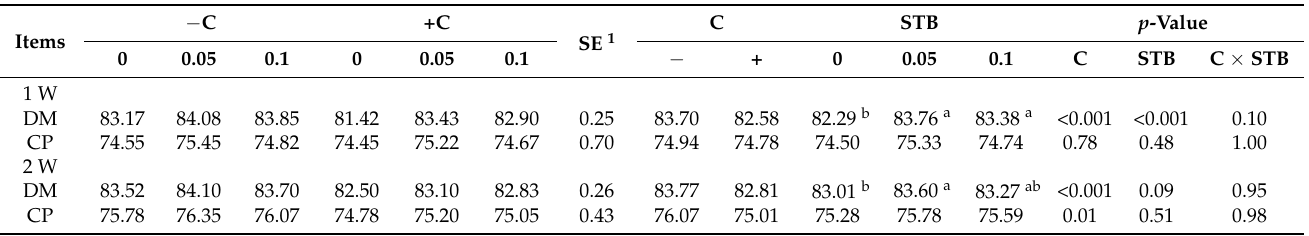
Table 4. Effects of stimbiotic supplementation on the nutrient digestibility of pigs challenged with